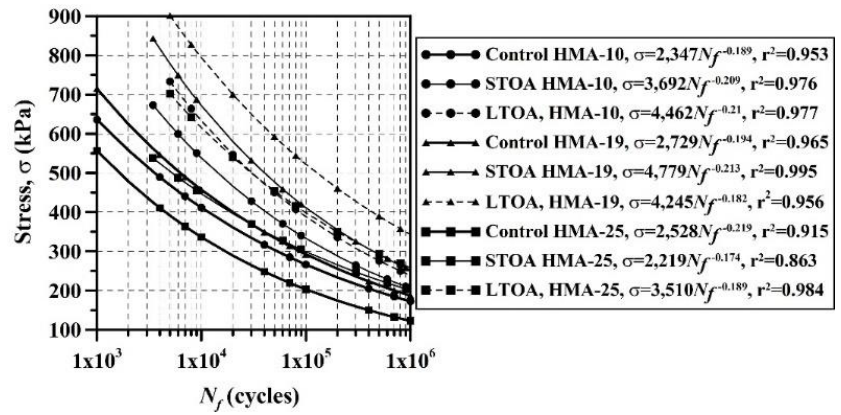
Figure 8. Fatigue test results.